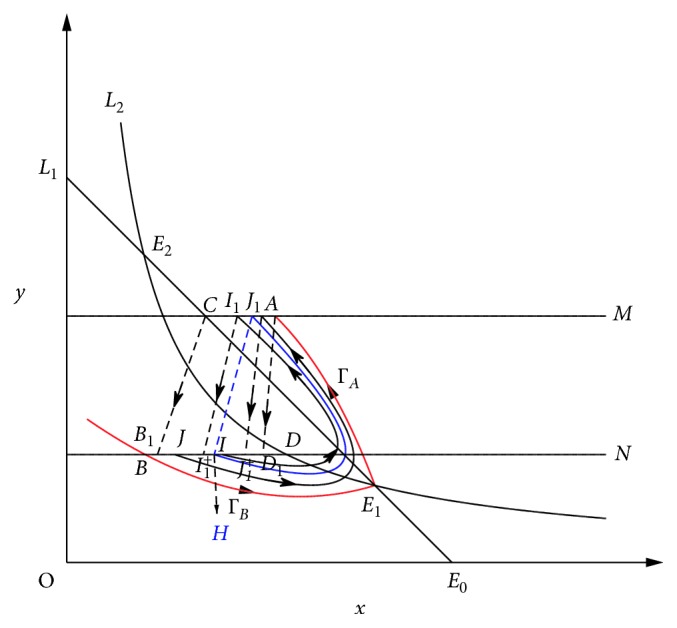
The monotonicity of the successor function G in the segment A1B1.